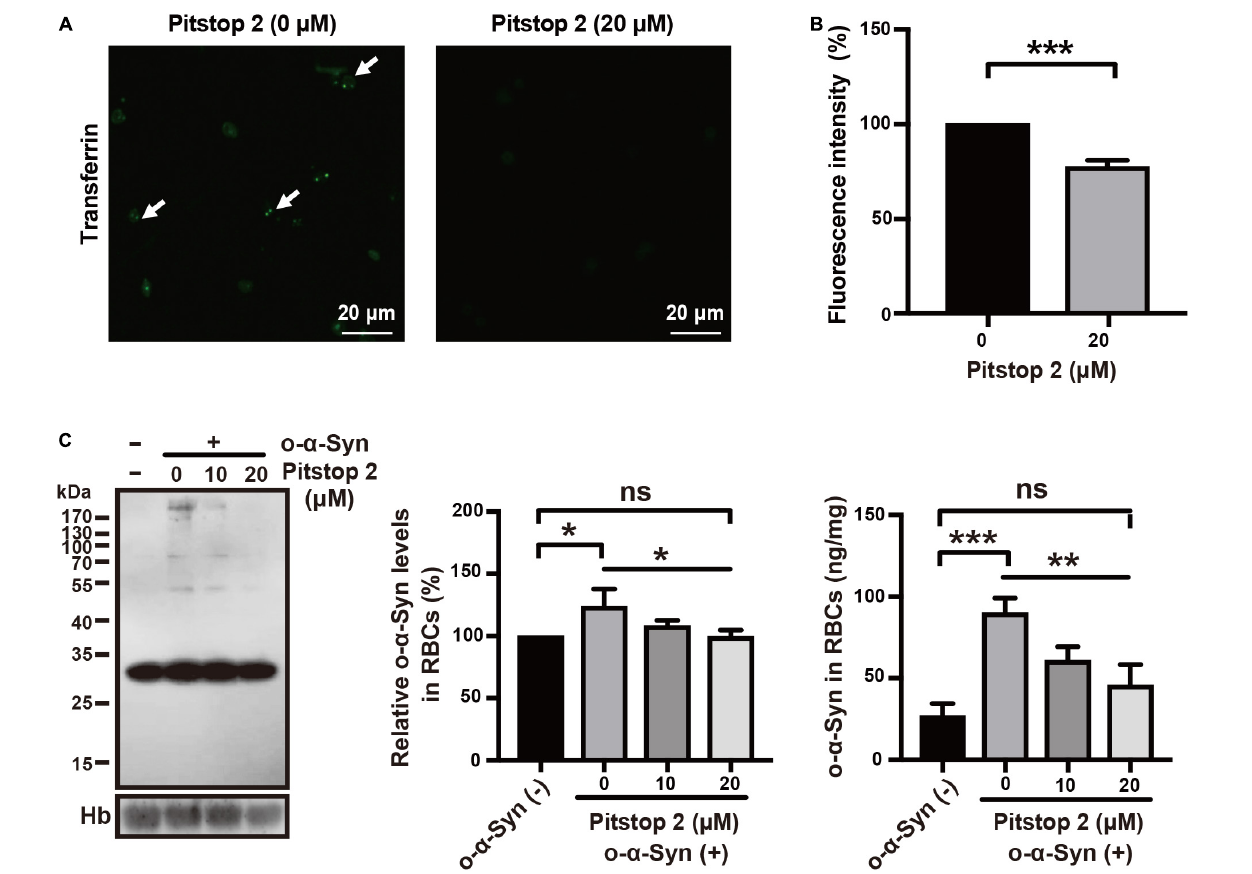
FIGURE 7 | Effect of pitstop 2 on o- α -Syn transport into RBCs. (A,B) RBCs were untreated or pretreated with 20 µ M of pitstop 2, and then incubated with 10 µ g/mL fluorescein-labeled transferrin for 2 h. In pitstop 2-treated cells, the endocytosis of fluorescein-labeled transferrin was inhibited, which in contrast to the untreated cells. (C) O- α -Syn levels in RBCs was measured after pretreatment with pitstop 2 and incubation with o- α -Syn. Pitstop 2 decreased intracellular o- α -Syn accumulation. Intracellular o- α -Syn levels in non-o- α -Syn-treated cells were considered 100%. n = 3; * p < 0.05, ** p < 0.01, *** p < 0.001; ns, not significant. Hb,